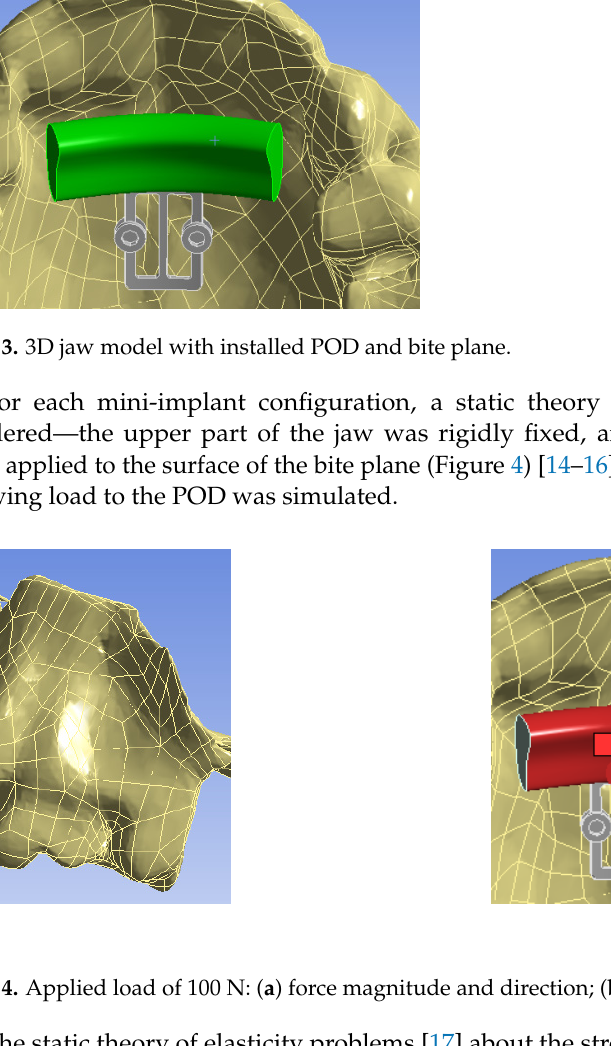
Figure 2. Four investigated mini-implant configurations. Bottom view. ( a ) Model 1. ( b ) Model 2. ( c ) Model 3. ( d ) Model 4.